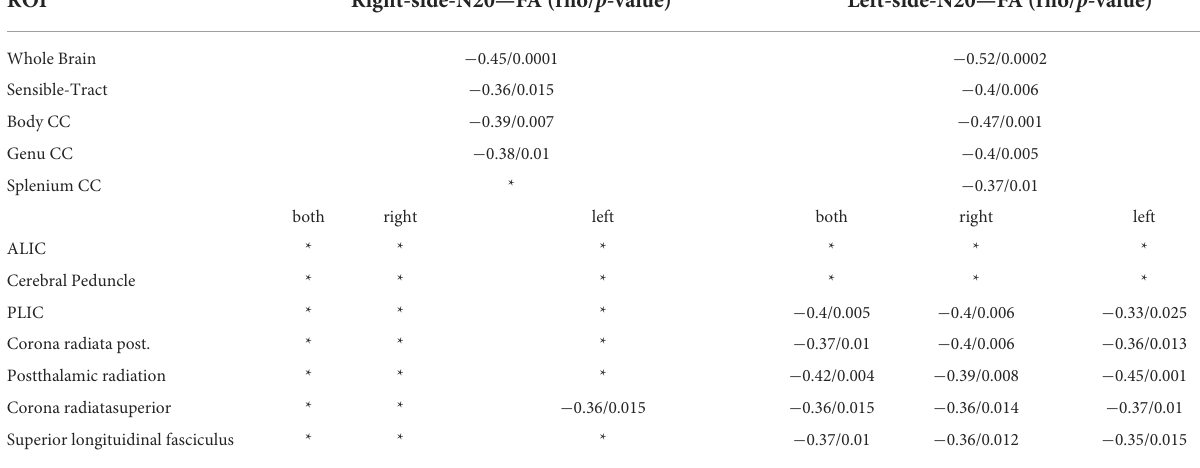
TABLE 2 Shown are the Spearman-Correlation values of N20-latencies from the right and left median nerve for selected ROIs and the DTI-derived parameter Fractional Anisotropie (FA).